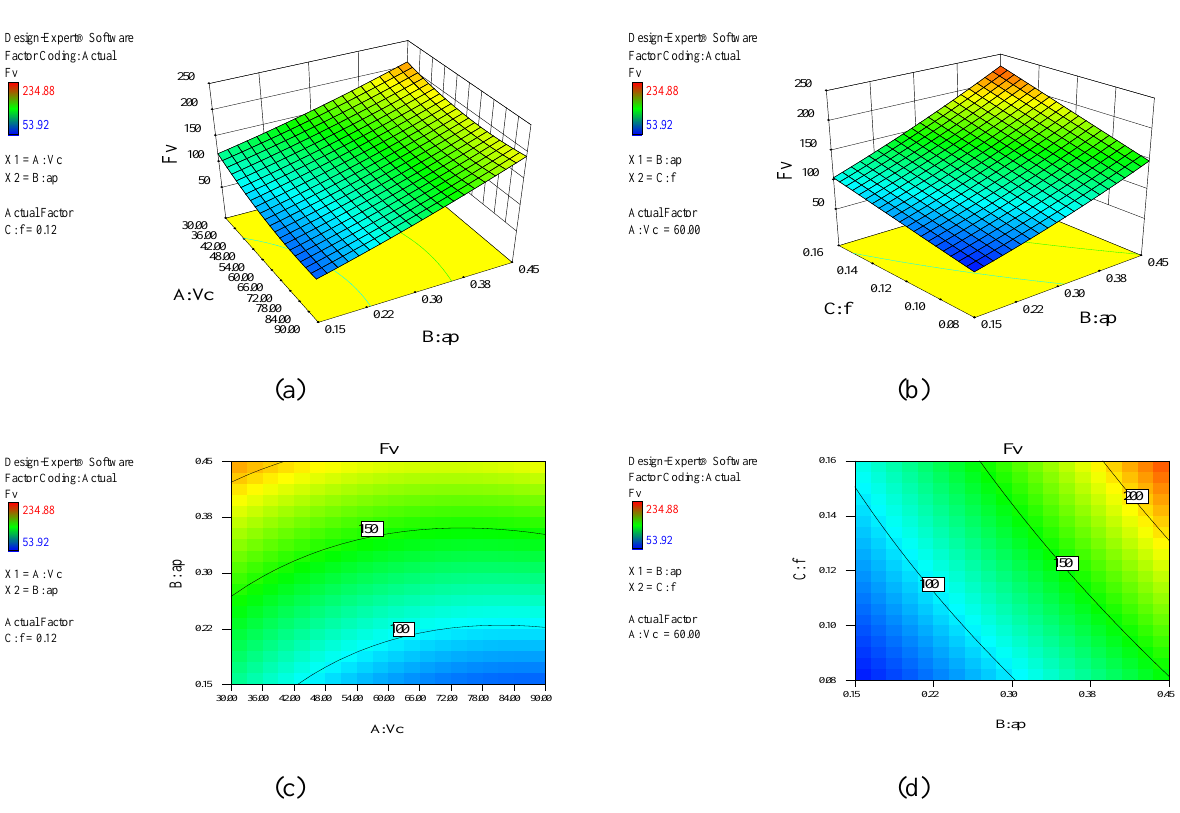
Fig. 14. 3D surface plot (a), (b) and Contour Plot (c), (d) for Fr